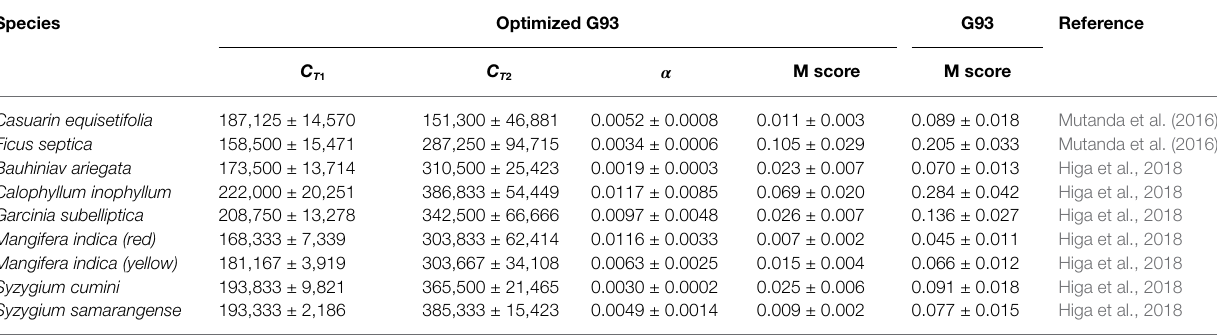
TABLE 1 | G93 parameters for various tropical species as obtained from optimization in Mutanda et al. (2016) and Higa et al. (2018). Species Optimized G93 G93 Reference C T 1 C T 2 α M score M